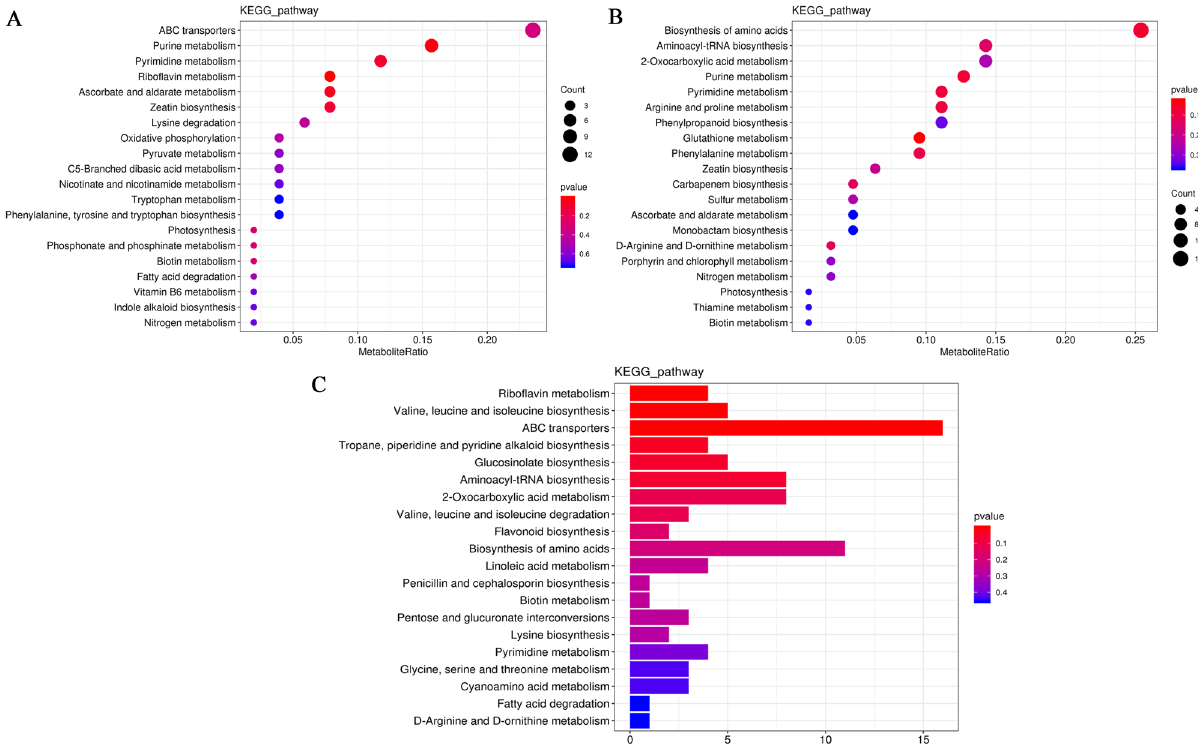
Figure 3. KEGG enrichment map of differential metabolites. The item of red dot is more significant than that of blue dot. ( A ) KEGG enrichment dotplot of differential metabolite (BCYC vs. BSHC). ( B ) KEGG enrichment dotplot of differential metabolite (BCZC vs. BSHC). ( C ) KEGG enrichment barplot of differential metabolite (BCYC vs.